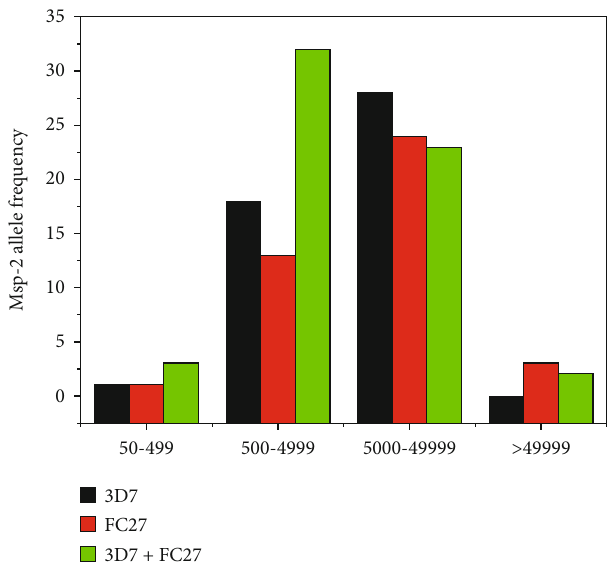
Figure 3: Comparison of the msp-2 gene allelic variant from malaria patients due to P. falciparum , who attended to di ff erent health facilities in the study area from September 2019 to August 2020 ( n = 148